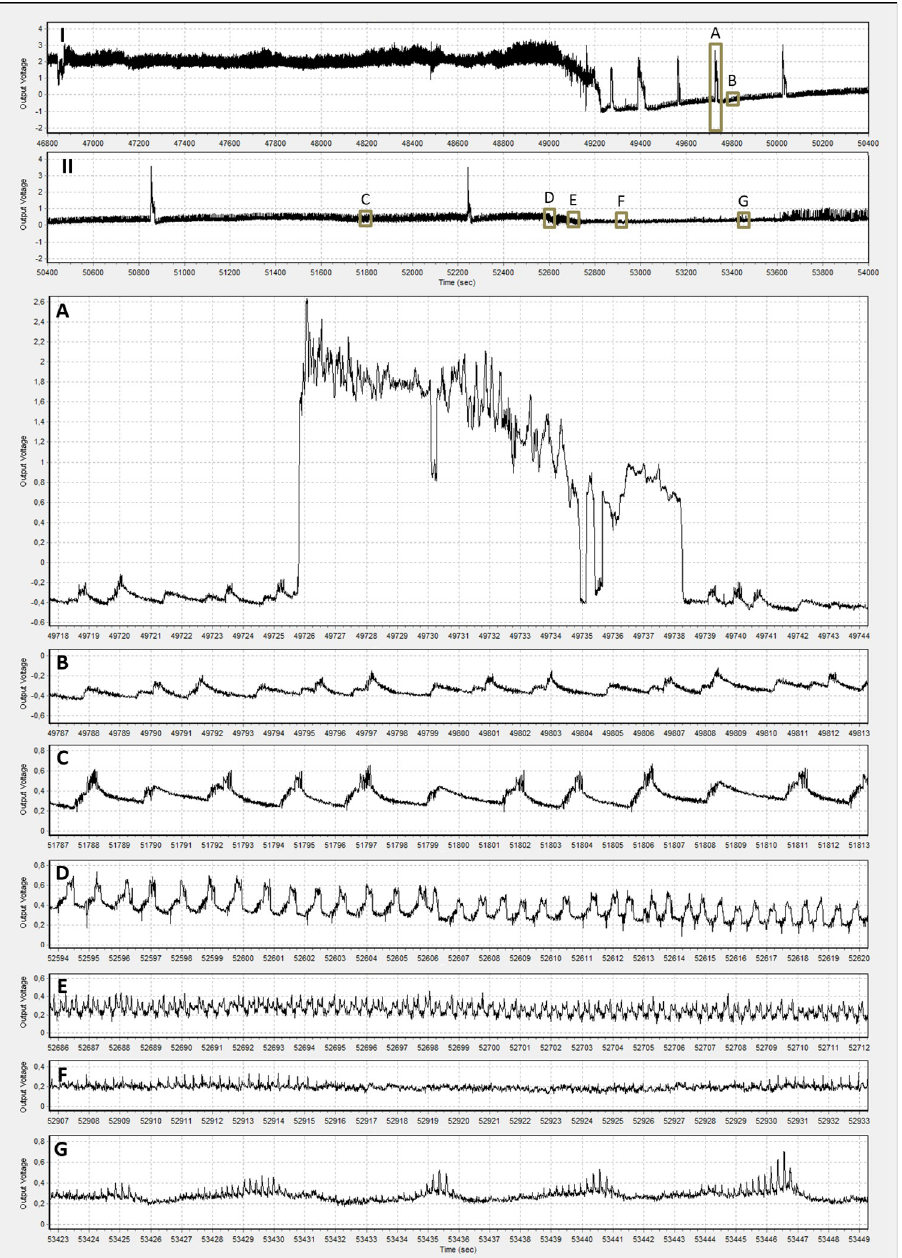
Fig 2. I and II: Progression of phloem conditioning (Dm4) to phloem ingestion (Dm5) of D . maidis insects with access to maize hybrids. Inlets: A: “spikes” of high amplitude and irregular shape. B-D: phloem conditioning. E: transition to phloem ingestion. F-G: phloem ingestion. The X axis indicates the time (seconds) from the beginning of the recording session. The sequence of waveforms was saved in ANA files in Stylet+, after assessing (identifying and measuring their time of occurrence) visually each waveform event. Dm1, Dm2, Dm3, Dm4, Dm5 and Dm6 waveforms were loaded in ANA files as C, G, Id11, E1, E2 and Id12, respectively. Several variables of probing behavior were calculated from ANA files using EPG-